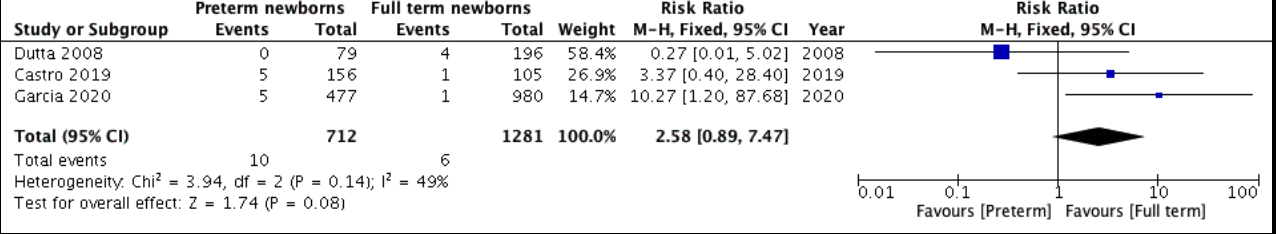
Figure 2. Forest plot comparison between the two patient groups in terms of the incidence of hernia recurrence.